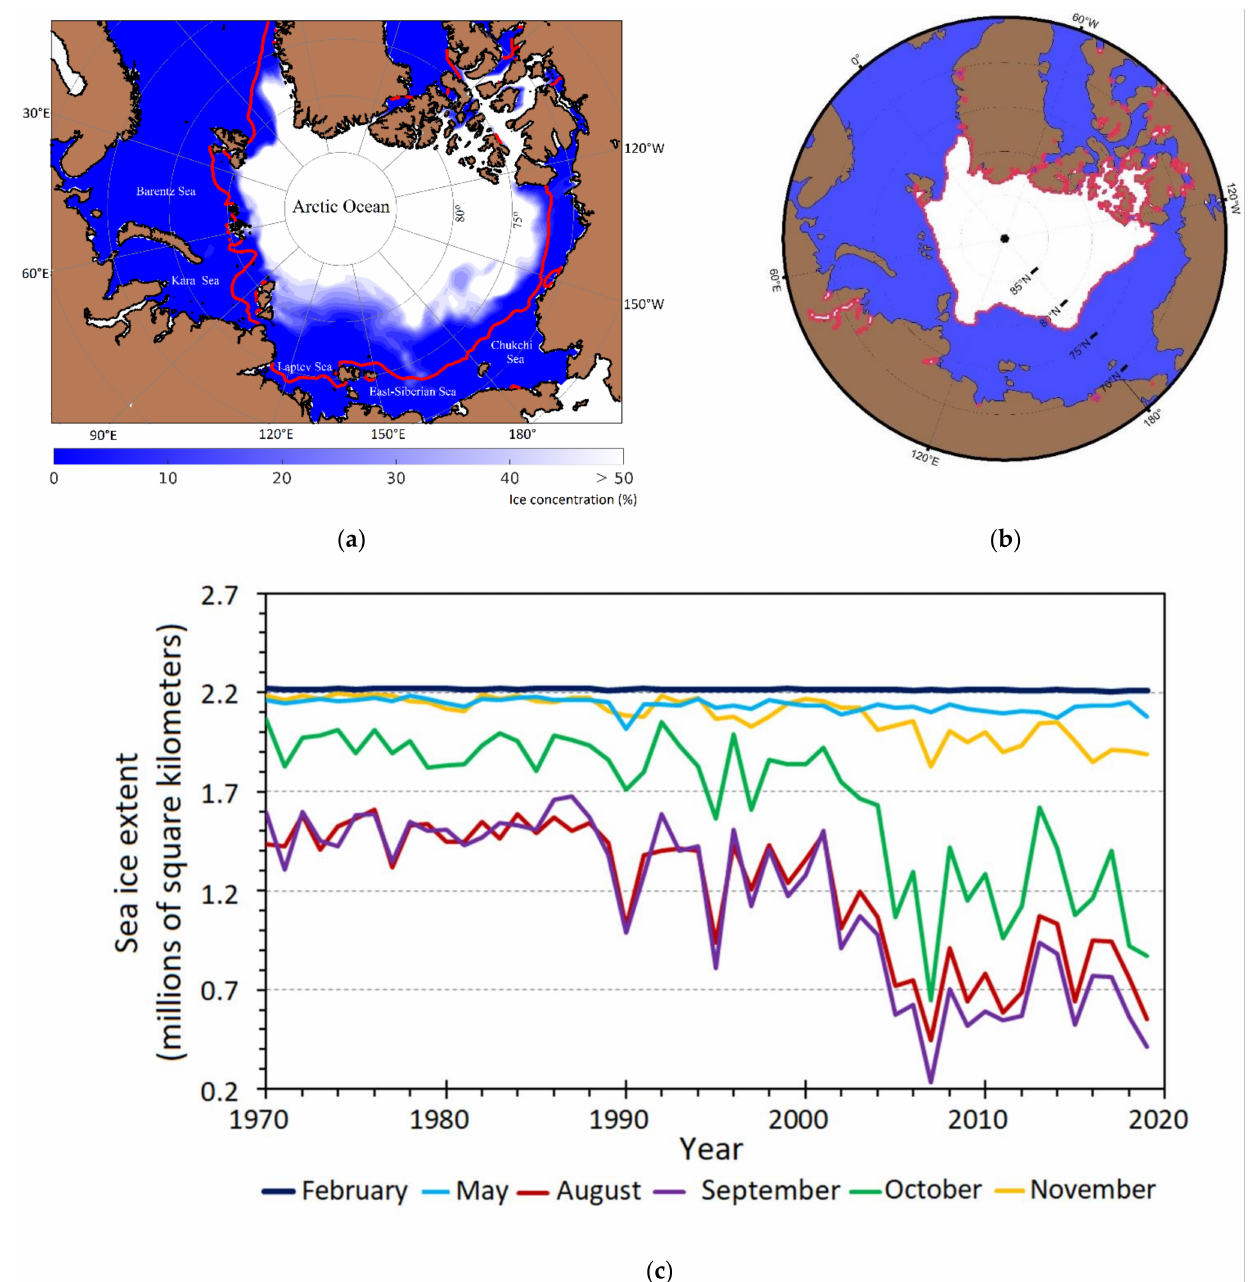
Figure 2. ( a ) Sea ice concentration simulated for September 2019. Redline shows minimum ice extent (15%) averaged for 2000–2010. ( b ) Ice edge position in September 2019. The sea ice extent was obtained using polygon shapefiles derived from publicly available satellite data collected for the period 1981–2020 (National Snow and Ice Data Center; NSIDC Adapted from [65]). ( c ) Time series of month sea ice extent simulated for February (dark blue), May (blue), August (red), September (violet), October (green), and November